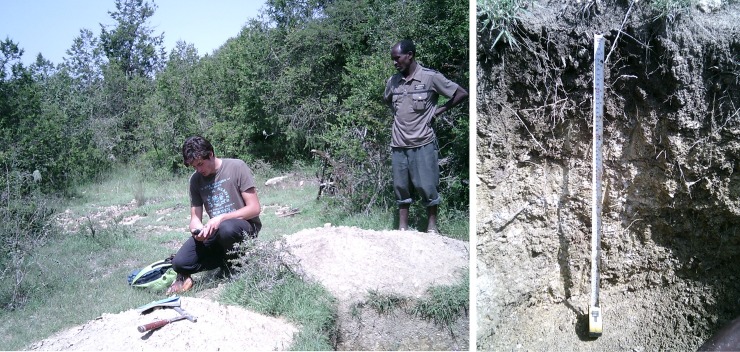
Location of soil profile pit R in Des’a forest (left) and profile R (Mollic Calcaric Cambisol, right).